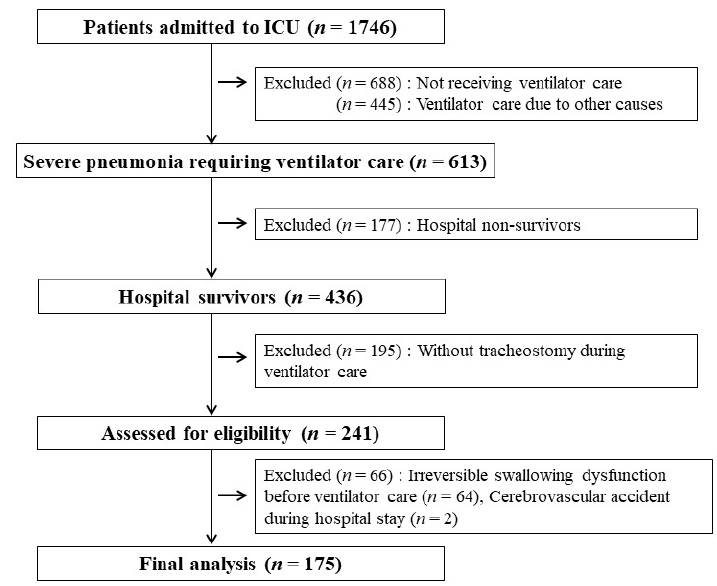
Figure 1. Flowchart of patient selection. Table 1. Clinical characteristics of total patients .